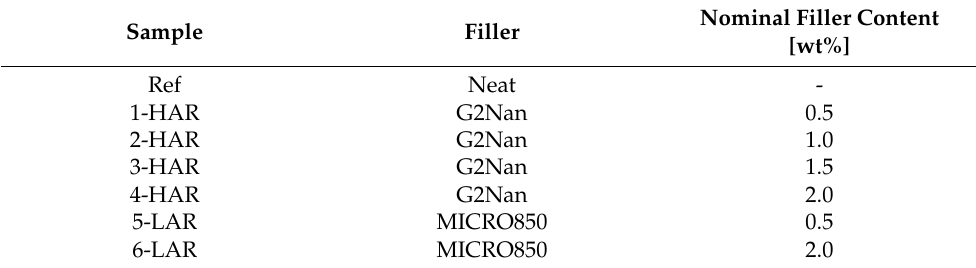
Table 1. List of fabricated